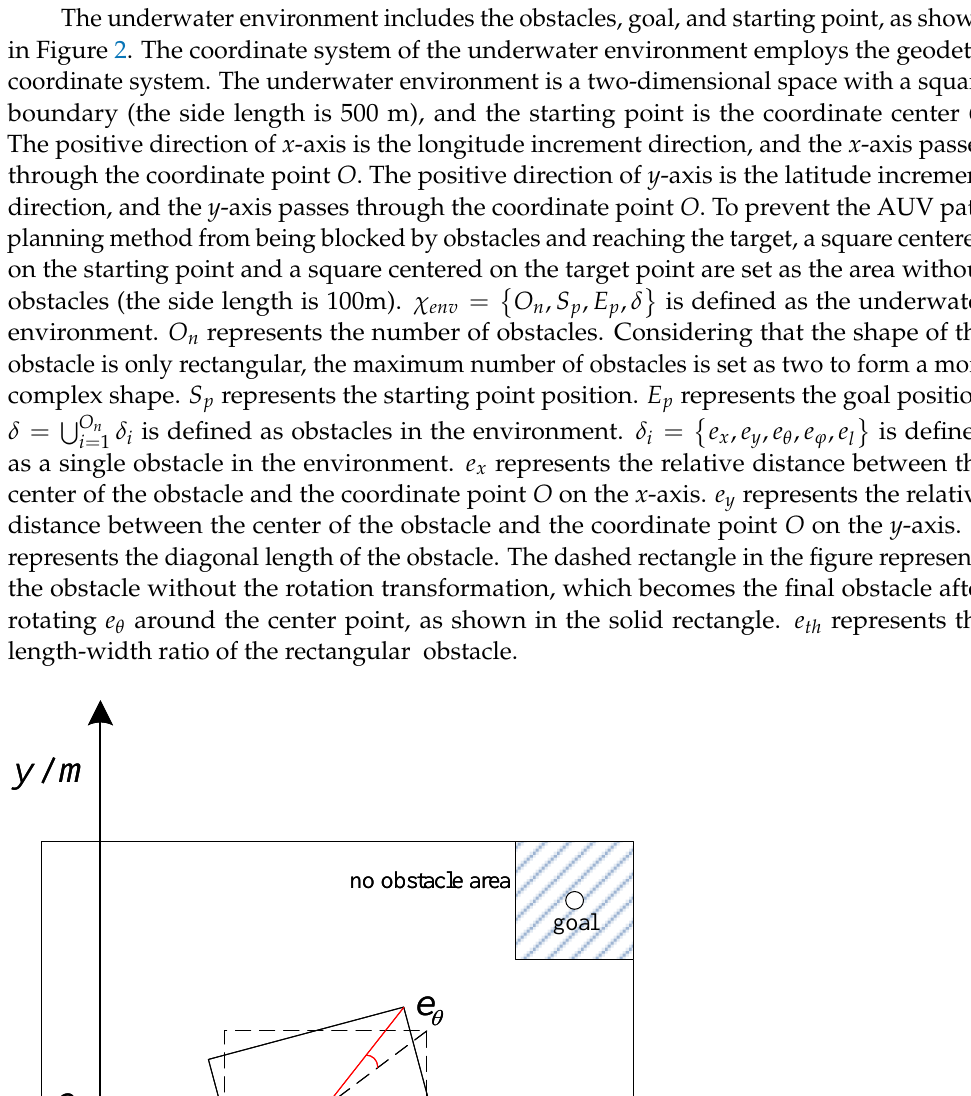
(cid:110) (cid:111) e t = s θ , s x , s y , s v is defined as the environment information of AUV. s θ t t t t